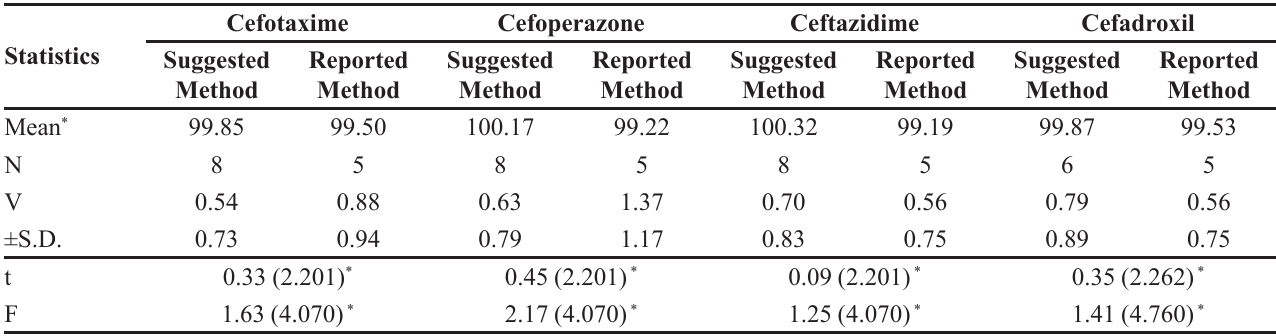
TABLE VII – The statistical data for the determination of cefotaxime, cefoperazone, ceftazidime and cefadroxil through silver nanoparticles formation